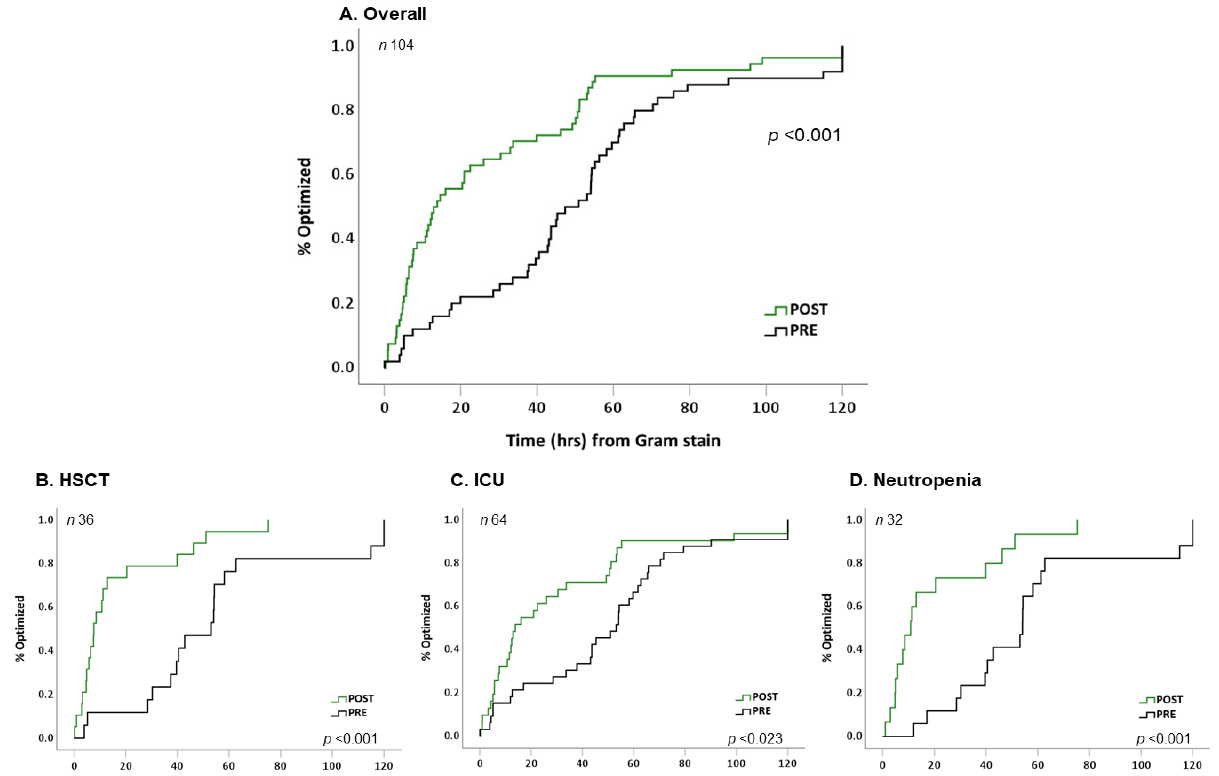
Figure 2. Time to optimal therapy by pre- or post-implementation. Kaplan–Meier (KM) plot depicting time to optimal therapy over 120 h from time of Gram-stain stratified by implementation group in the ( A ) overall cohort, ( B ) hematopoietic stem cell transplantation (HSCT) subgroup, ( C ) Intensive care unit (ICU) subgroup, ( D ) neutropenia subgroup. p by log-rank test. Black line, pre-implementation group; green line, post-implementation group. Table 3. Cox proportional model for time to optimal therapy.